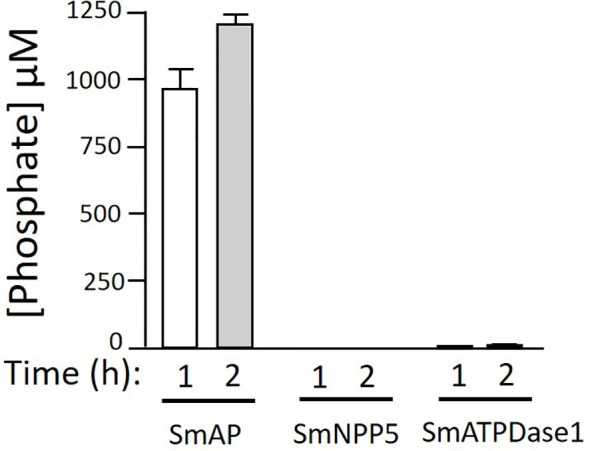
rSmAP can hydrolyze PLP. Phosphate generation (µM, mean +/-SD) by recombinant SmAP, SmNPP5, or SmATPDase1 in assay buffer containing PLP as substrate, at the indicated time points. No appreciable levels of phosphate were detected when rSmNPP5 or rSmATPDase1 were tested.